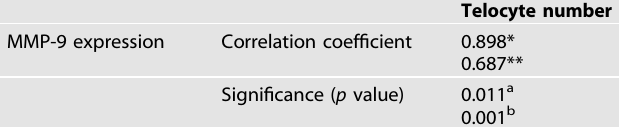
Table 1. Pearson ’ s correlation of MMP-9 expression and telocyte number in HCC